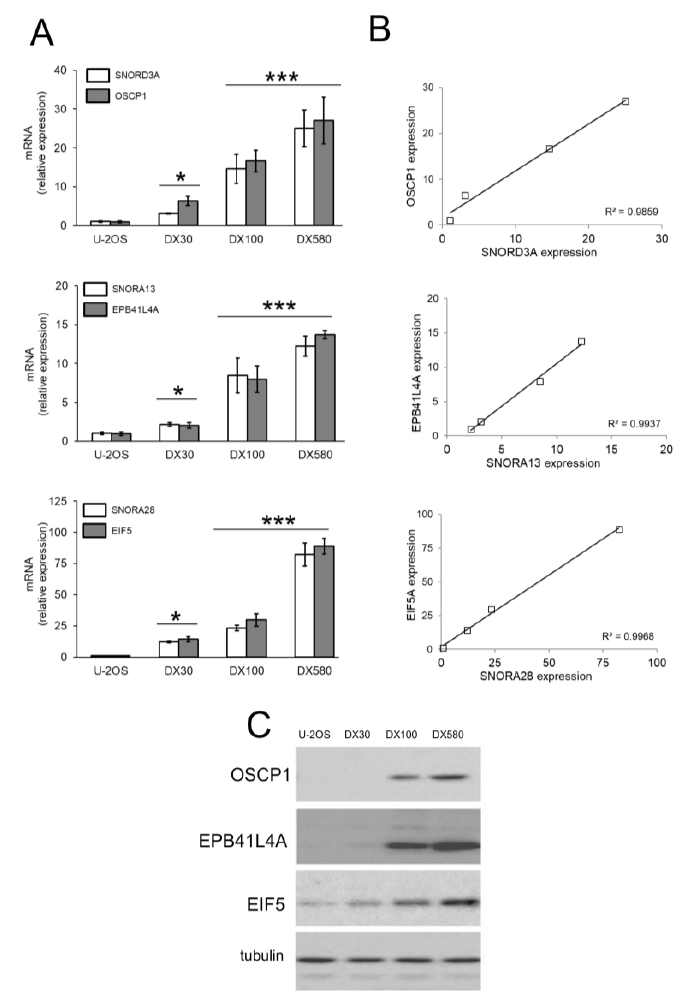
Figure 2. SNORD3A , SNORA13 and SNORA28 up-regulation in doxorubicin-resistant osteosarcoma cells. ( A ) mRNA levels of SNORD3A , SNORA13 and SNORA28 and their host genes ( OSCP1